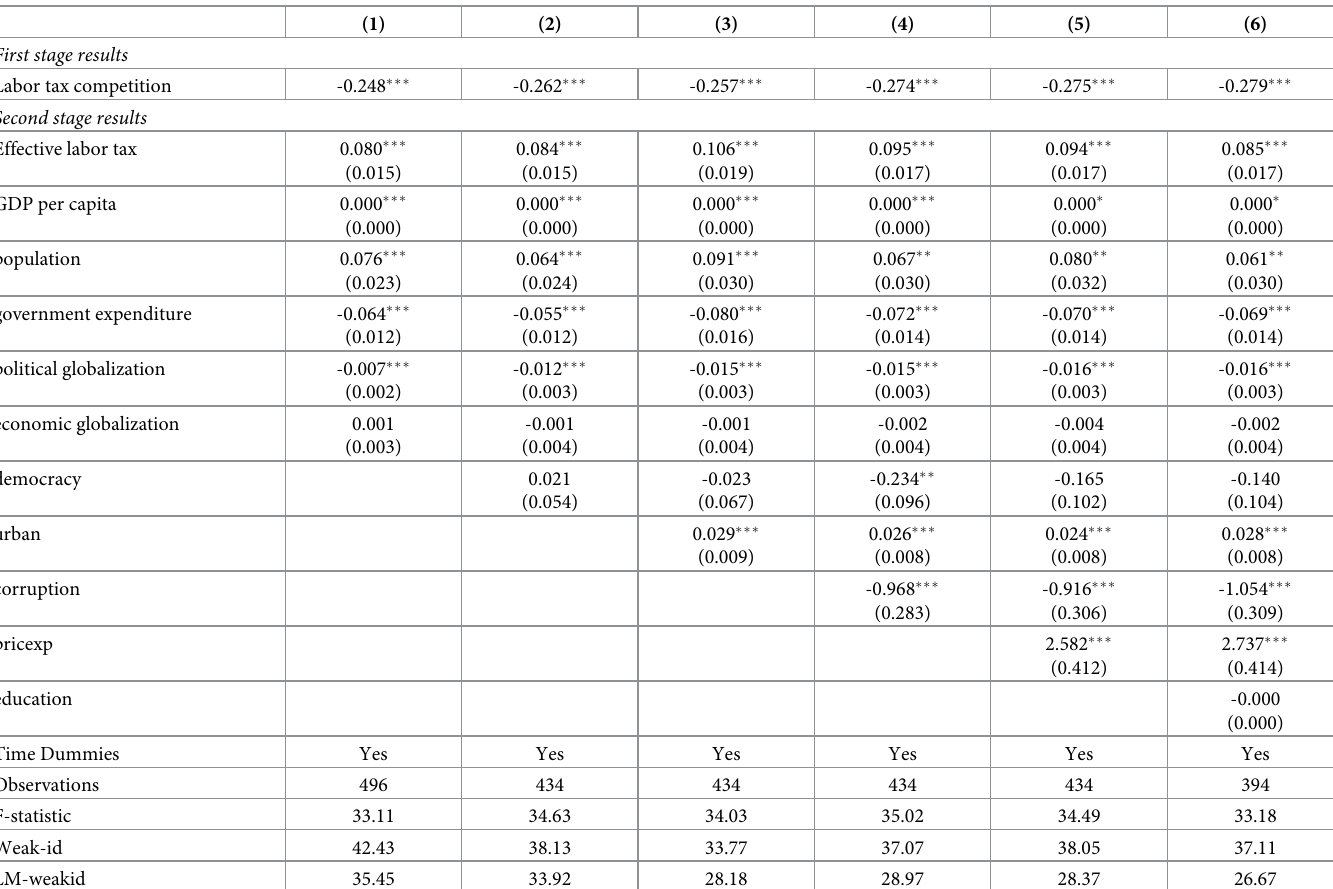
Table 1. The impact of taxation on economic sophistication: Effective labor tax